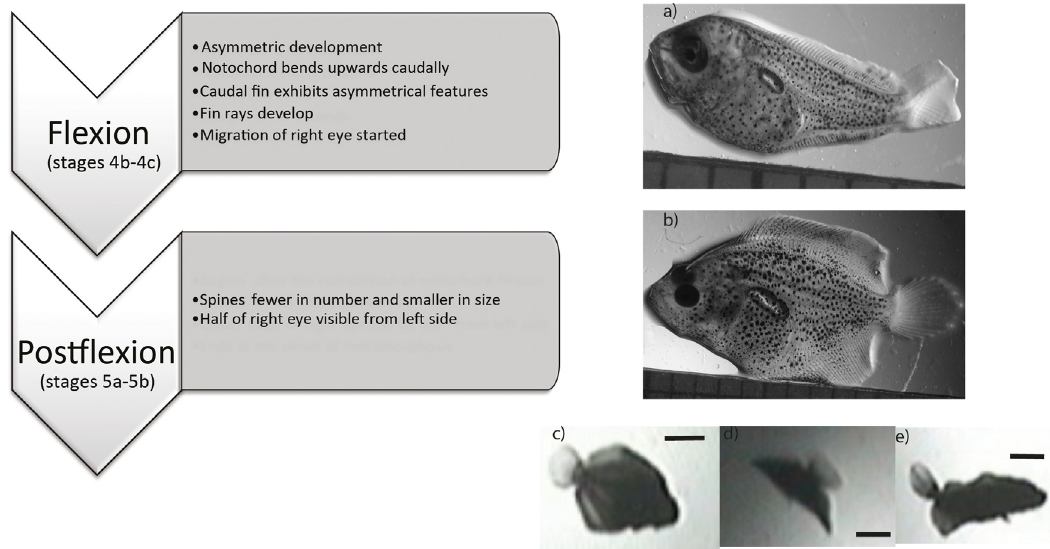
Fig. 1. Examples of turbot larvae in the development stage: (a) fl exion, (b) post- fl exion with the description of each stage and pictures of post- fl exion turbot larvae in upright (c) and different degrees of tilted positions: (d) 38 ° , (e) ∼ 90 ° . Scale bars 0.25cm for (c) – (e). Table 2. De fi nition of turbot larval categories, or Modal Action Patterns (MAPs, after Brown,